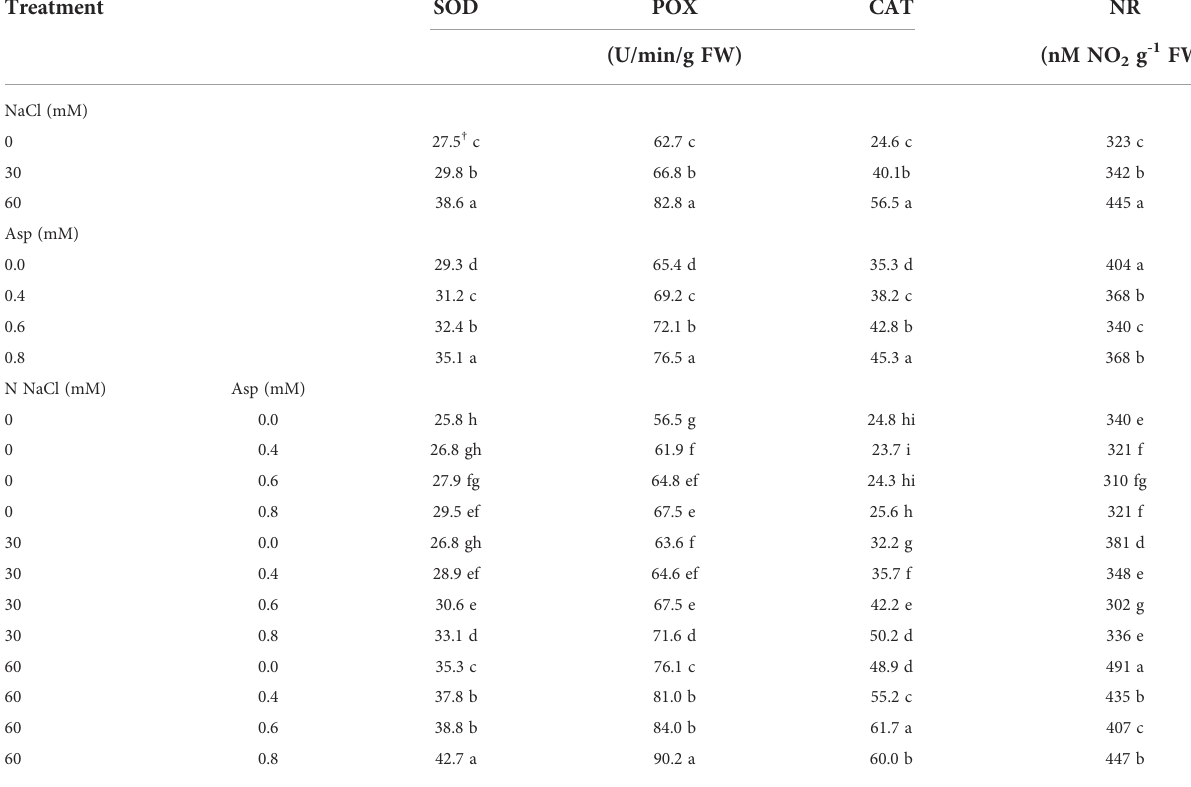
TABLE 4 Effect of aspartic acid (Asp) on enzymatic antioxidants (superoxide dismutase; SOD, peroxidase; POX, catalase; CAT, and nitrate reductase; NR) in wheat plants grown under salt stress (NaCl) for 60 days. Treatment